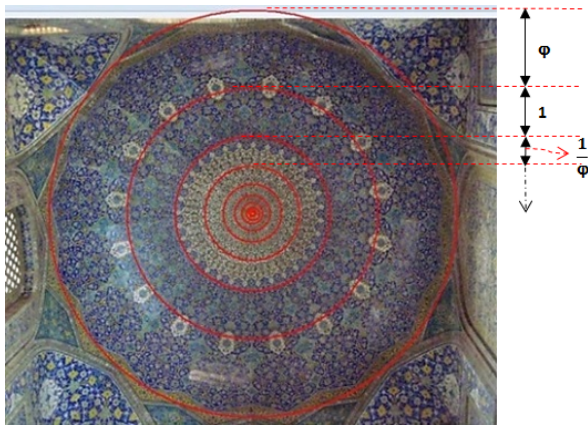
Figure 18: Conformity of dividing lines in tiles, with golden dis- tances between golden